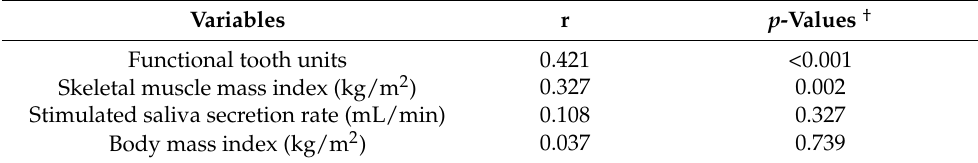
Table 3. Correlations between mixing ability index and each variable (N = 84).